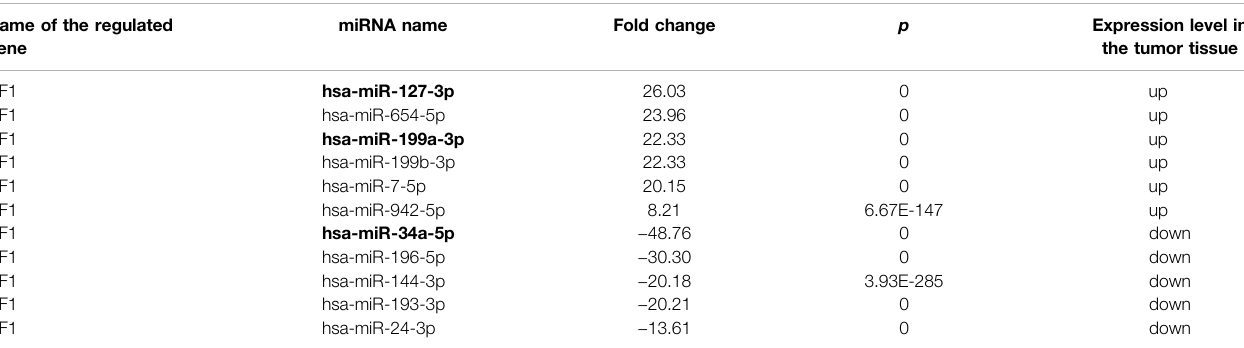
Bold values represents that the three NF1- related microRNAs were chosen and veri fi ed.